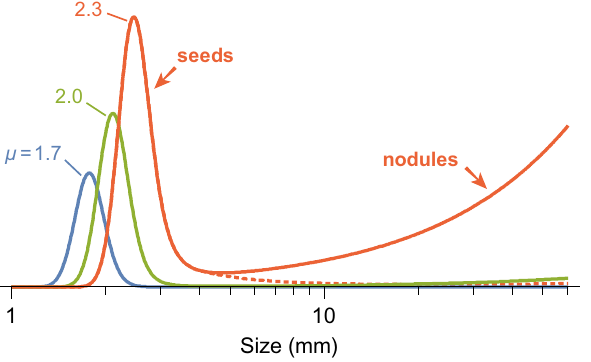
Figure 5. Steady-state distribution of growing ferromanganese nodule seeds predicted by Eq. (3) with size segregation parameters from microtektite fits of core MD90-0961 (Table 1), a nodule grow rate of 5 mm/ Myr, and L = 6 cm, D s = 22 cm 2 /kyr and v b = 0.5 cm/kyr as representative SML properties at a water depth of ~ 4000 m. Results are shown for lognormal size distributions of depositing seeds (solid lines) with σ = 0.1 and three values of µ (numbers in mm). The dashed line represents the case of µ = 2.3 mm when the linear increase of v t ( s ) stops at s = 4